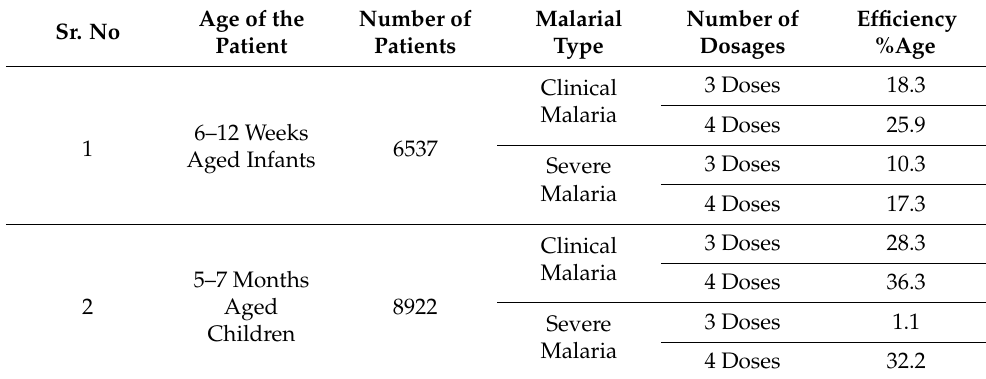
Table 1. Percentage efficiency of phase III clinical testing of RTS, S vaccine. Sr.